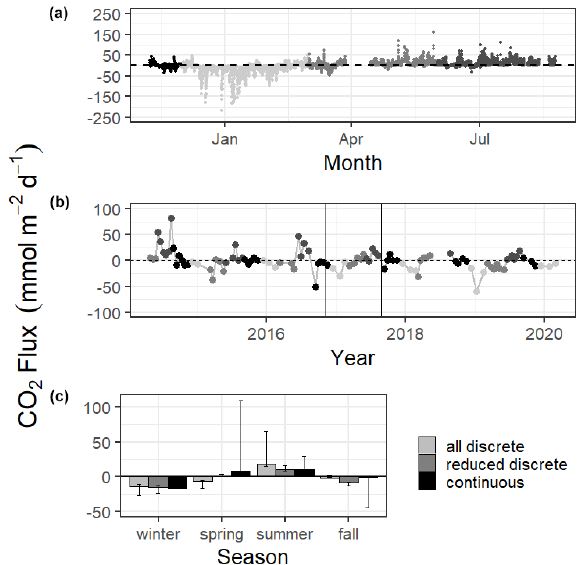
Figure 3. CO 2 flux calculated over the sampling periods from con- tinuous (a) and discrete (b) data. Gray scale in (a) and (b) denote different seasons. Vertical lines in (b) denote the time period of con- tinuous monitoring. (c) shows the seasonal mean CO 2 flux. Error bars represent mean CO 2 flux using Ho (2006) and Raymond and Cole (2001) wind speed parameterizations. Table 1. Coefficients of linear discriminants (LD) from LDA using continuous sensor data and other environmental parameters. Dis- criminants for both diel and seasonal variability